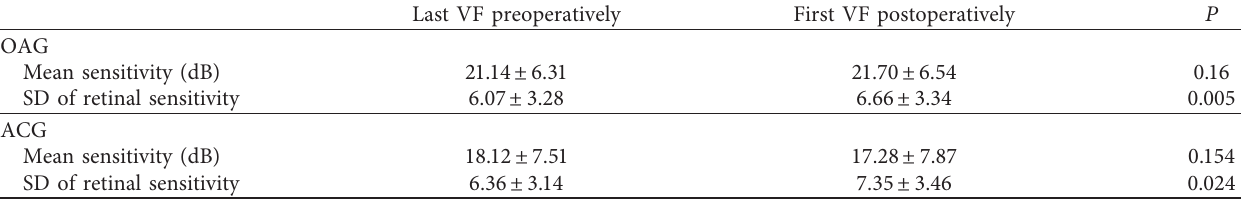
Table 2: Change in mean sensitivity and variance of VF before and after cataract surgery in patients with OAG and ACG. Last VF preoperatively